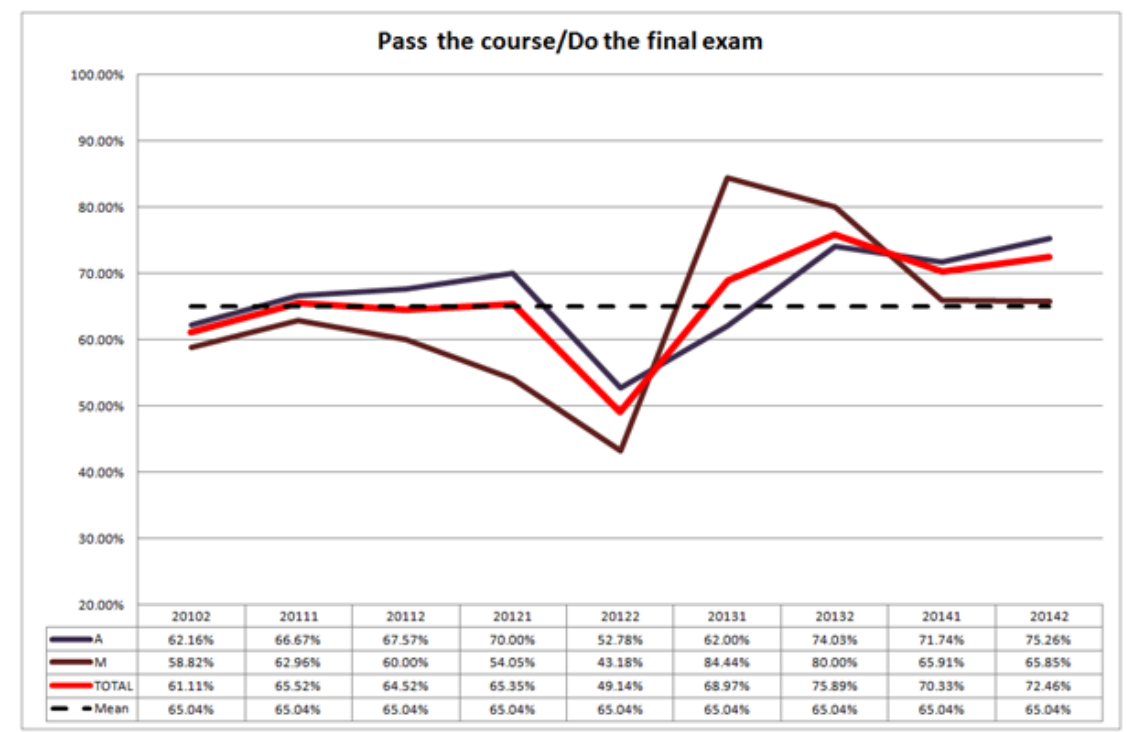
Figure 5. Students passing the course with respect to the total taking the final